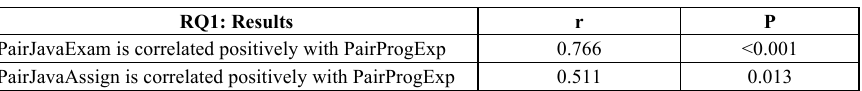
Table 3. Results summary of RQ1